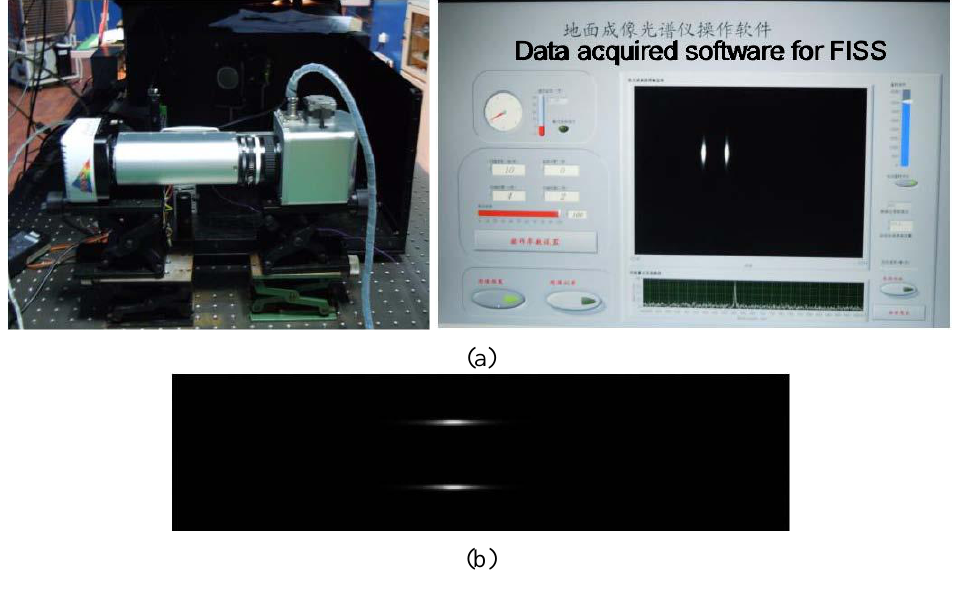
Figure 5. (a) Laboratory spectral calibration set-up and (b) Imaging results for FISS from 589 nm monochromatic light: two symmetrical narrow lines for each monochromatic light were detected due to the “round trip” of the scan mirror within